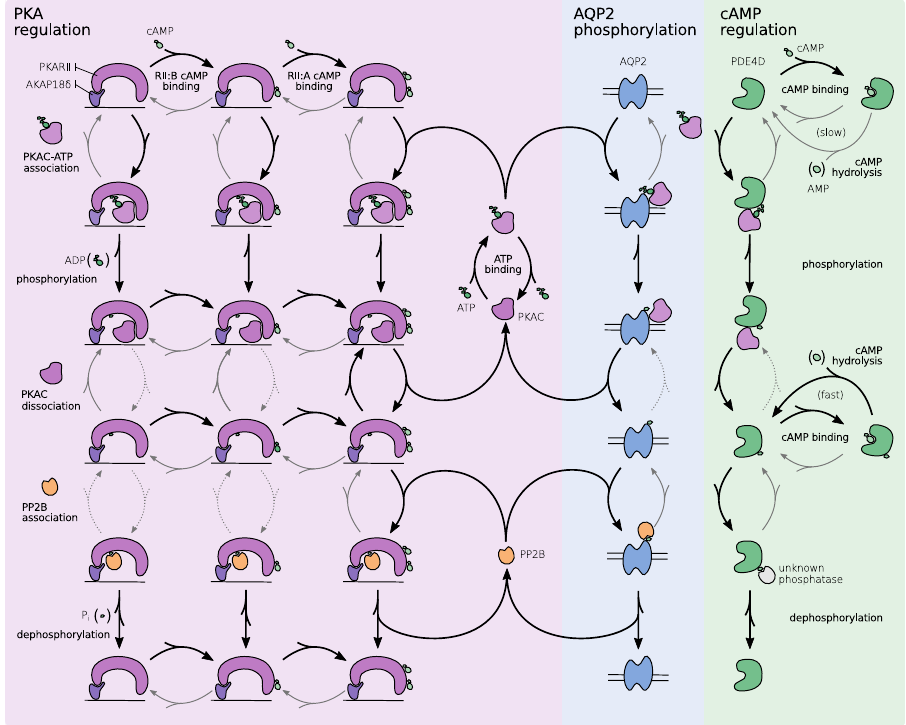
Fig. 2 PKA regulation and effect on AQP2 and PDE4 phosphorylation. The network of possible reactions during signal processing as a response to cAMP. Black arrows indicate preferred and fast reactions, gray arrows show slow but still signi fi cant reactions, gray and dotted arrows are considered negligible in their frequency. The following reactions in each row from top to bottom: PKA and substrate association, substrate phosphorylation, substrate dissociation, phosphatase and substrate association, and PP2B phosphorylation and release. Substrates are only displayed once and considered implicitly row and column-wise. PKAC is only released upon binding of a second cAMP to the regulatory subunit. A negative feedback loop is present, where the released PKAC phosphorylates PDE4, leading to an increased PDE4 activity which decreases the cAMP concentration. Abbreviations: protein kinase A type II regulatory subunit (PKARII), cAMP binding site A/B at PKARII (RII:A/B), protein kinase A catalytic subunit (PKAC), A-kinase anchoring protein 18 variant δ (AKAP18 δ ), Serine/threonine-protein phosphatase 2B (PP2B), aquaporin 2 (AQP2), phosphodiesterase 4D